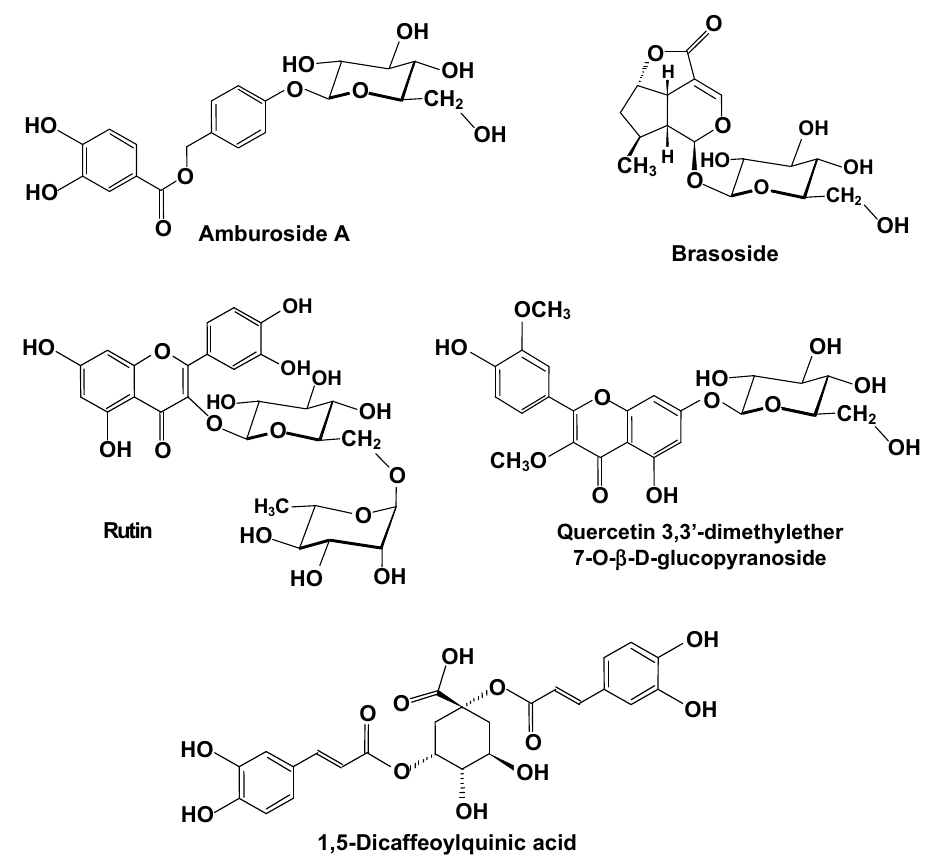
Figure 5. Brasoside and examples of phenolic compounds possibly involved in the hepatoprotective action of several Brazilian plants.